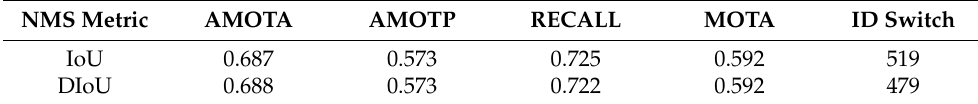
Table 1. NMS for IoU and DIoU in the detection process with GIoU in association two stage. NMS